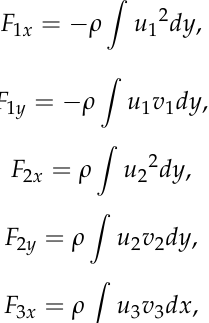
Figure 7. Setup for measurement of flow velocity fields using the PIV system: ( a ) connection dia- gram; ( b ) side view from the camera.